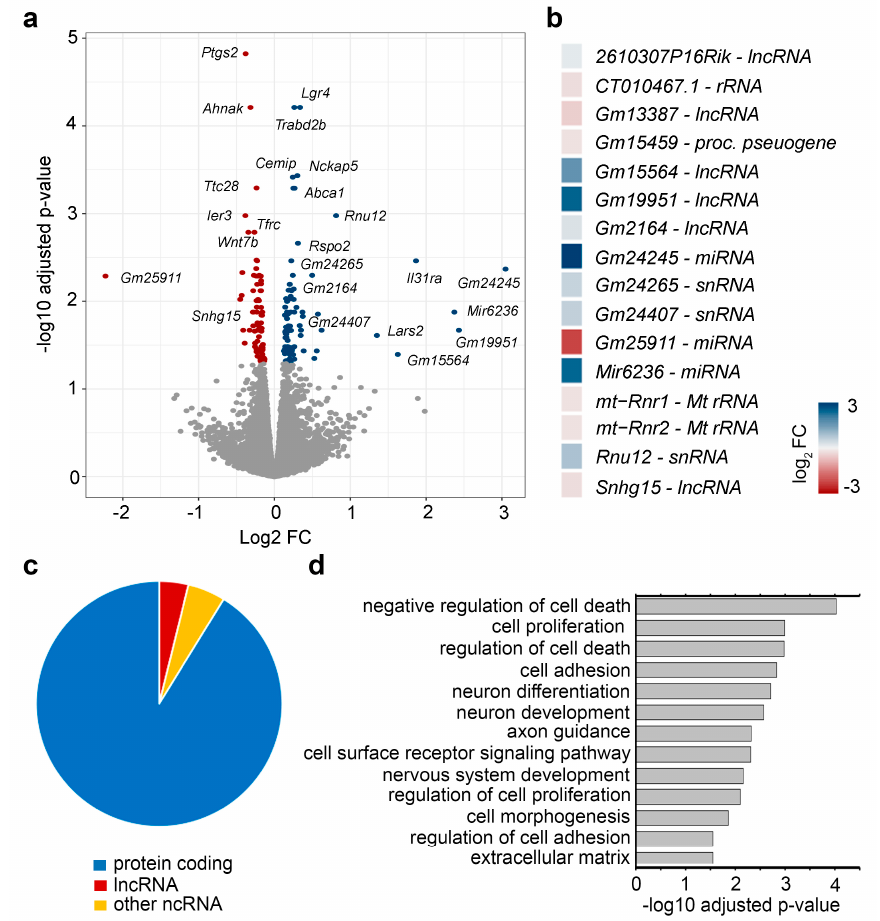
Figure 2. Differential gene expression analysis of ephrinA5-Fc-treated CB cells versus controls (Fc) determined by RNA sequencing of nuclear-enriched and ribosomal-depleted RNA. ( a ) Volcano plot illustrates the genes identified as significantly up- and down-regulated upon ephrinA5-Fc stimulation. The negative log10 of the adjusted p -value is plotted against the log2 fold change of each gene. Significantly up-regulated genes are depicted in blue, and significantly down-regulated genes are illustrated in red. Sequencing was performed as N = 3 biological replicates per con- dition. ( b ) Heatmap of differentially expressed non-coding RNAs. ( c ) Pie chart diagram depict- ing the proportions of protein-coding versus non-coding RNAs found as differentially expressed. ( d ) Bar plot depicting significant gene ontology terms for the differentially expressed genes after ephrinA5-Fc